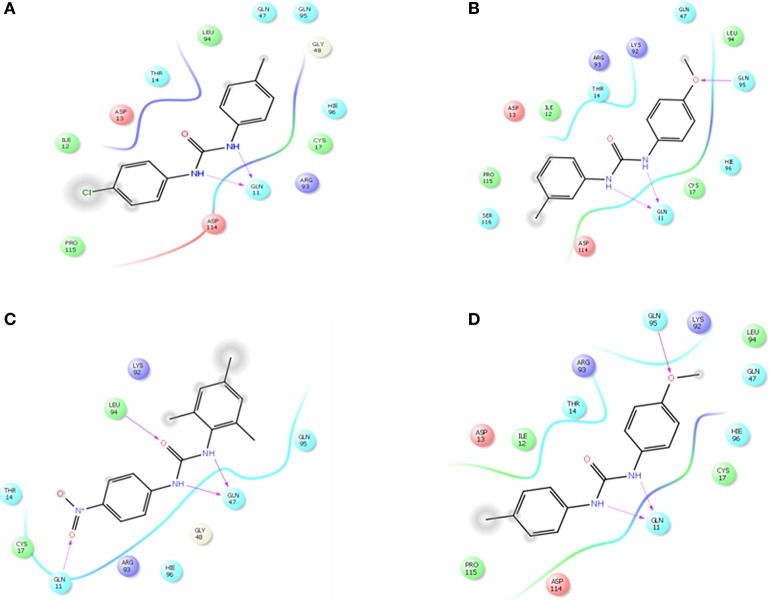
Schematic 2D representation of interaction of derivatives of ComAI with PEP domain of ComA. (A) ComAI1; (B) ComAI2; (C) ComAI3; (D) ComAI4.